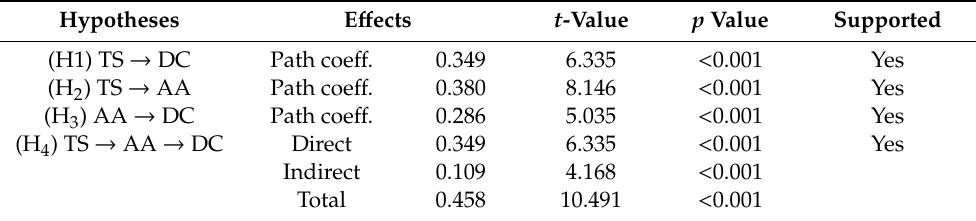
Table 6. Hypotheses testing for direct and mediating